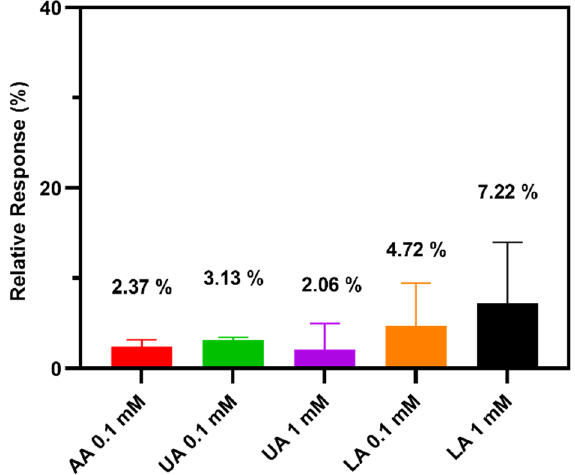
Figure 5. Relative responses of the TEMPO-CNC glucose sensor toward interfering species (0.1 mM L-ascorbic acid, 0.1 and 1 mM uric acid, 0.1 and 1 mM L-lactic acid) in a 1 mM glucose standard solution in phosphate buffer. n = 3 for each condition; 1 mM glucose without interfering species is defined as 100 % response.